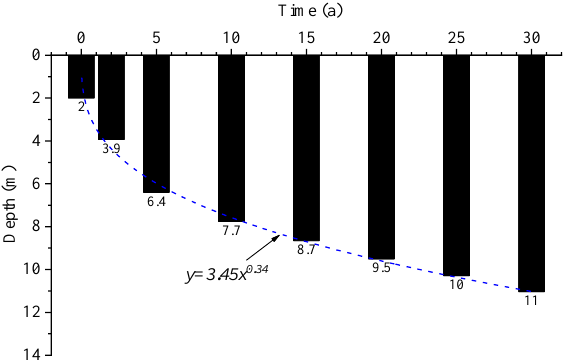
Figure 7. Permafrost table beneath the pipeline centerline over 30 years.